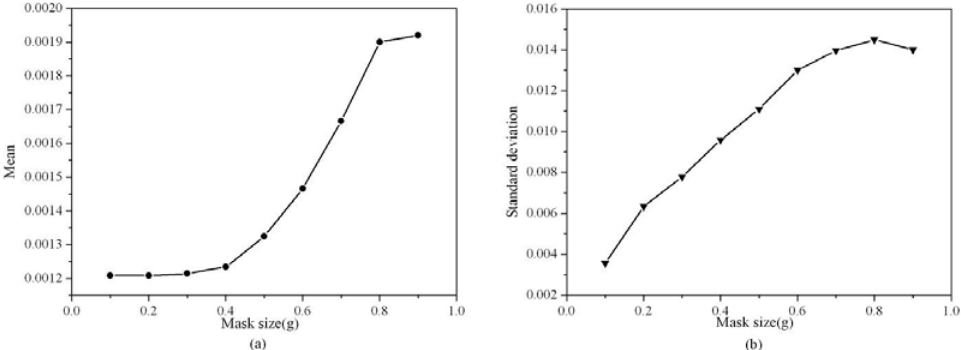
in the reference area by using xx